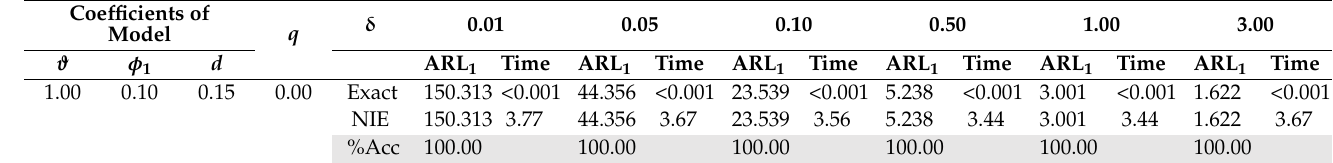
Table 4. The ARL 1 results using the exact formula and the numerical IE technique for ARFI(1, d ) processes running on the modified EWMA control chart with λ =